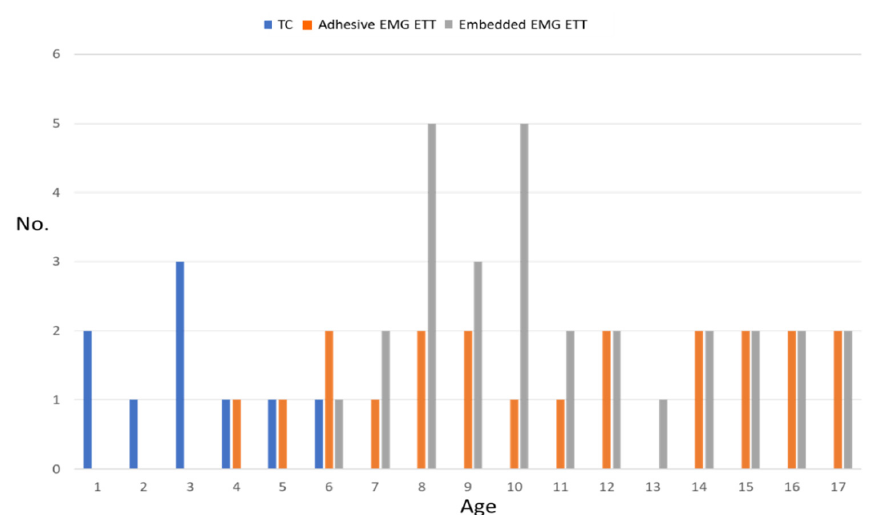
Figure 4. Stratification of IONM technology used according to age. Abbreviations: No: number; IONM: intraoperative neural monitoring; TC: transcartilage recording electrode; EMG: electromyog- raphy; ETT: endotracheal